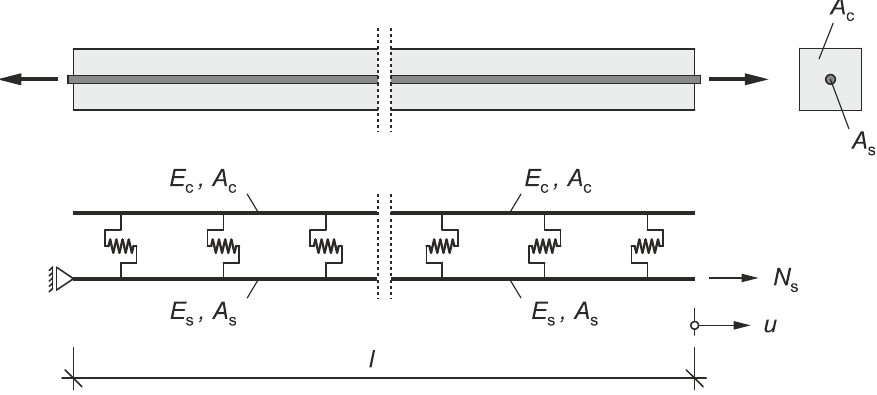
Figure 2. Crack propagation model (CPM).